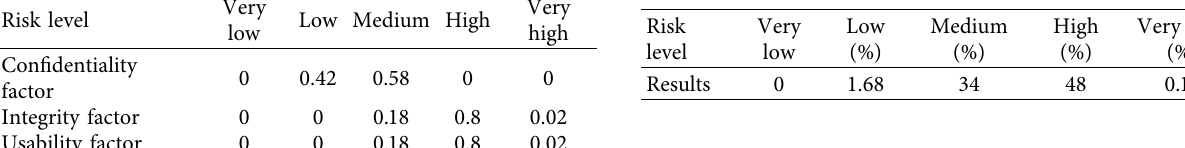
Table 4: Membership probability of the assessment result.